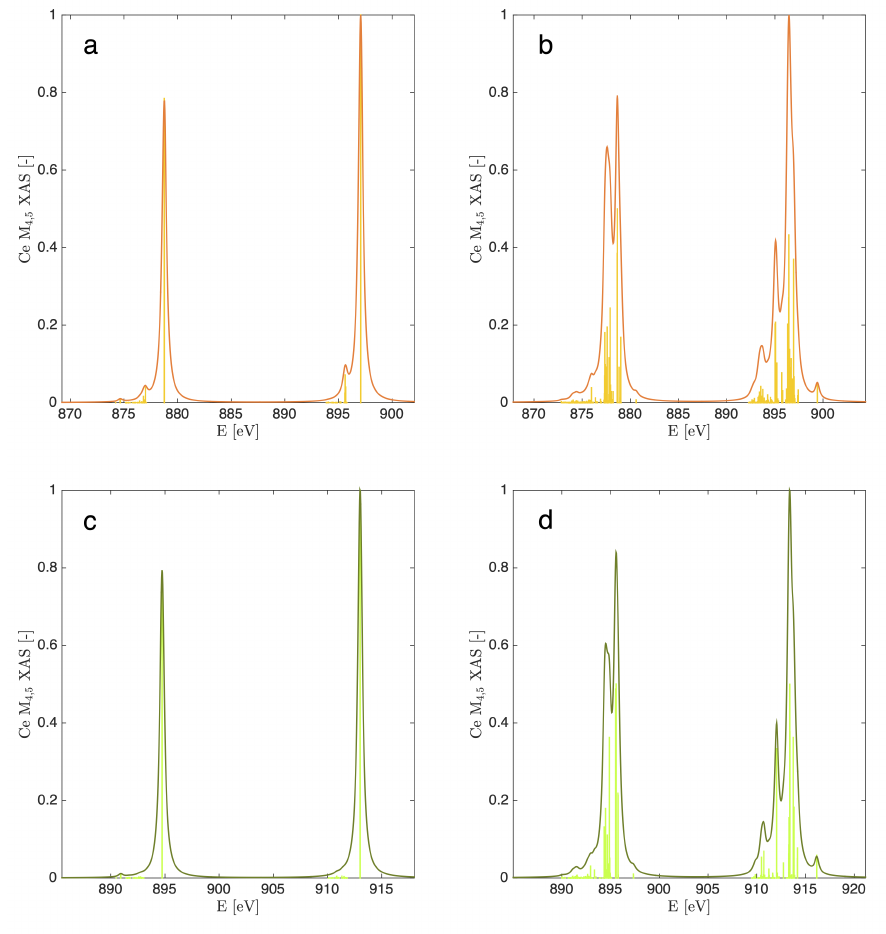
Figure 3. Calculated spectral profiles of the Ce M 4,5 -edge XAS of [Ce(COT) 2 ] (left) and [Ce(COT) 2 ] − (right), obtained from the LFDFT calculations using the PBE [37] ( a , b ) and PBE0 [39,40] ( c , d ) DFT functional. The light orange and green color bars represent the oscillator strengths of the electric- dipole 4 f n ←− 3 d 9 4 f n + 1 , with n = 0, and 1. The Darker orange and green curves represent the broadening of the oscillator strengths with Lorentzian function with half-width at half maximum parameter of 0.25